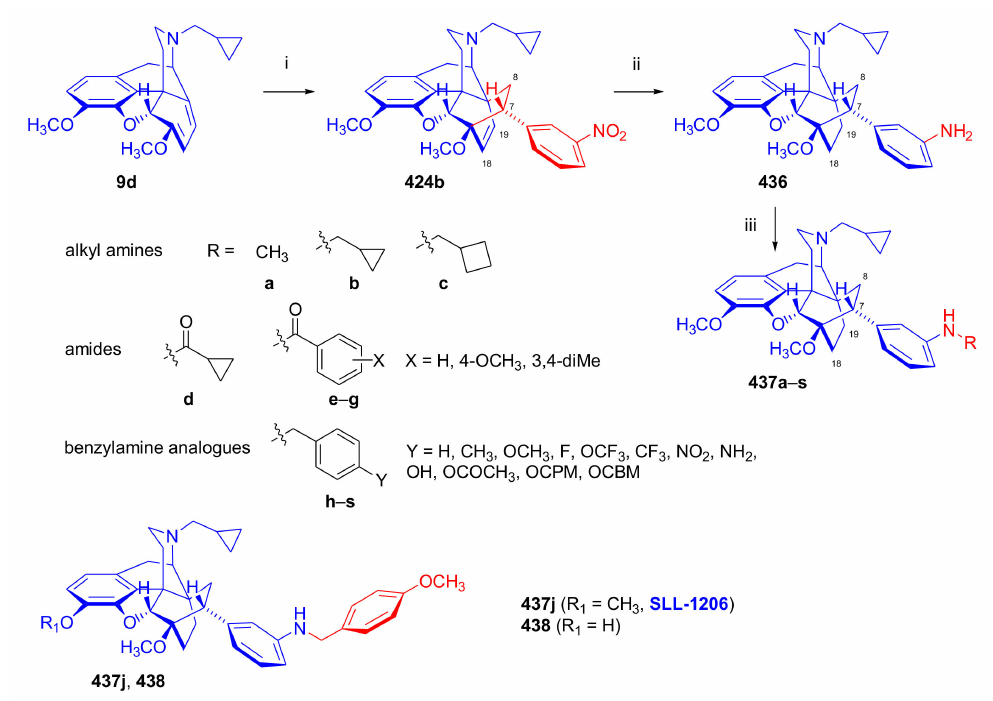
Figure 109. Synthesis of 7 α -( m -substituted-phenyl)- N 17 -cyclopropylmethyl-6,14-etheno morphinans. Reagents and conditions : (i): 3-nitrostyrene, xylene, reflux, 30 h, 46%; (ii): H 2 , Pd-C, MeOH, 4.4 bar, 25 ◦ C, 92%; and (iii): (A) alkyl amines: R = Me: (1): Cbz-Cl, DIPEA, CH 2 Cl 2 , 35 ◦ C, (2): LiAlH 4 , THF, 0 ◦ C, 47%; or (B) haloalkanes, Na 2 CO 3 , DMF, 80 ◦ C, 15–78%; C -amides: carboxylic acid, HATU, DIPEA, or acid chlorides, Et 3 N, CH 2 Cl 2 , RT,